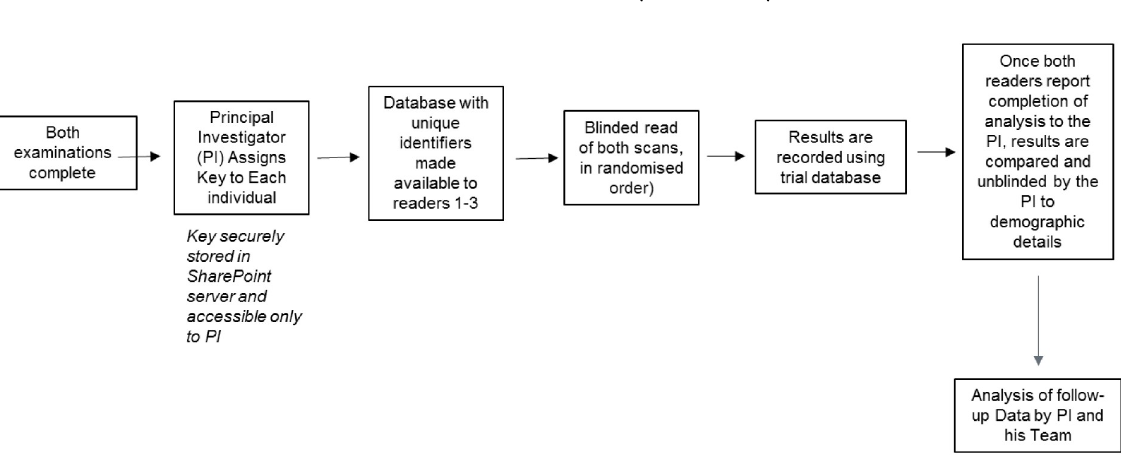
Fig 3. Study flow chart detailing consent